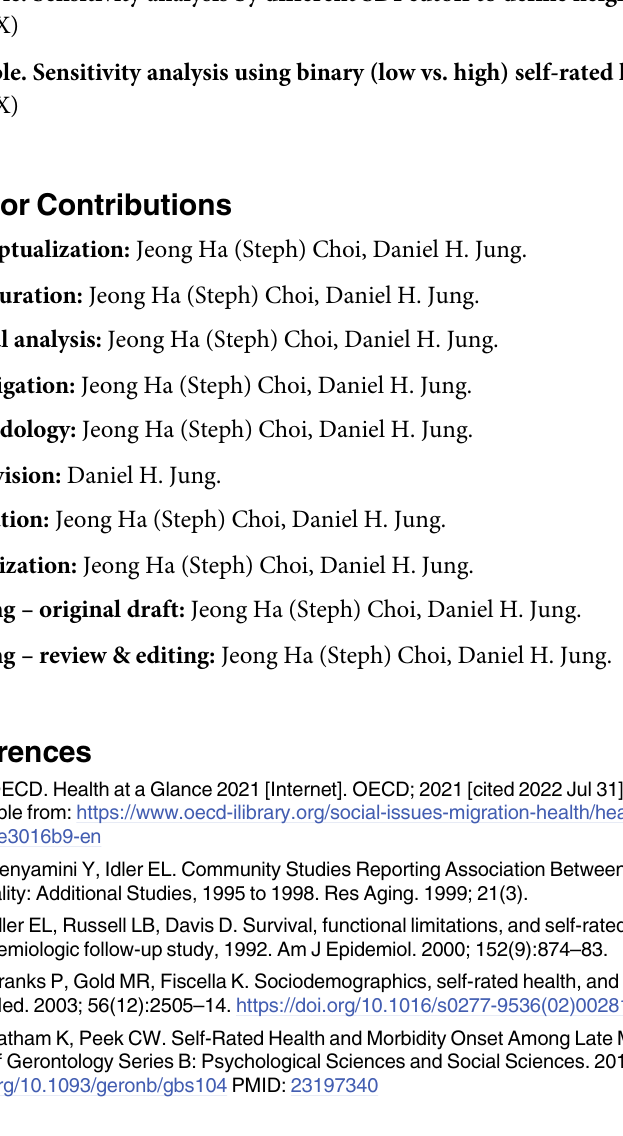
S1 Table. Sensitivity analysis using ADL severity. S2 Table. Sensitivity analysis by different SDI cutoff to define neighborhood disadvantage. S3 Table. Sensitivity analysis using binary (low vs. high) self-rated